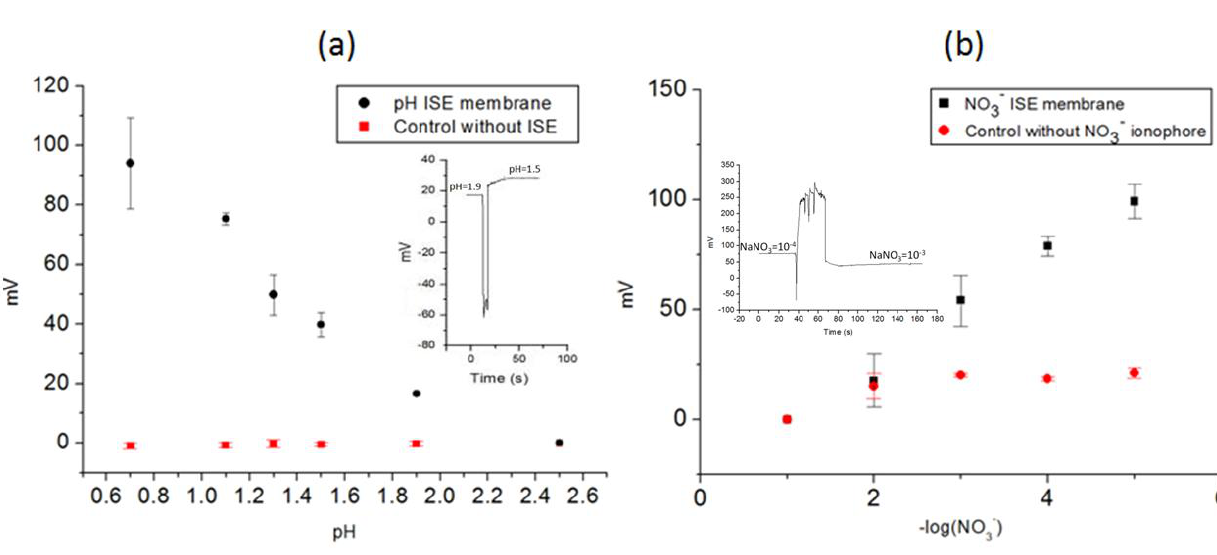
Figure 7. Potentiometry measurements with all-solid-state pH (reproduced with permission of Elsevier from reference [8]) ( a ) and nitrate sensors ( b ) and their control experiments (a, b) were performed to test the effect of the ISE membrane. Inset: A single step change response for the pH and the nitrate ISE.